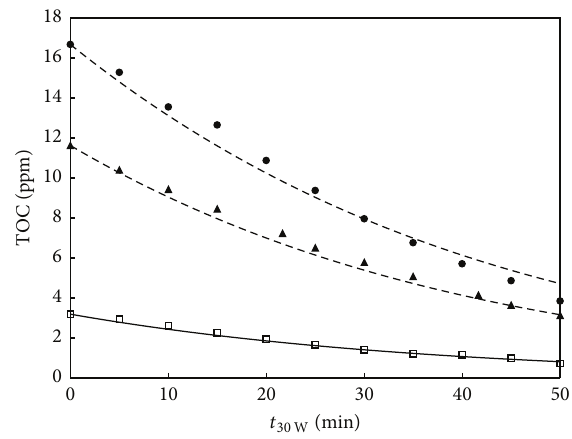
Figure 4: Experimental fitting of the selected model for the DCA: 30 ppm ( ◻ ); 60 ppm ( 󳵳 ); 120ppm ( ∙ ). a minimum 𝑅 2 of 0.983 and a maximum standard deviation of 0.60